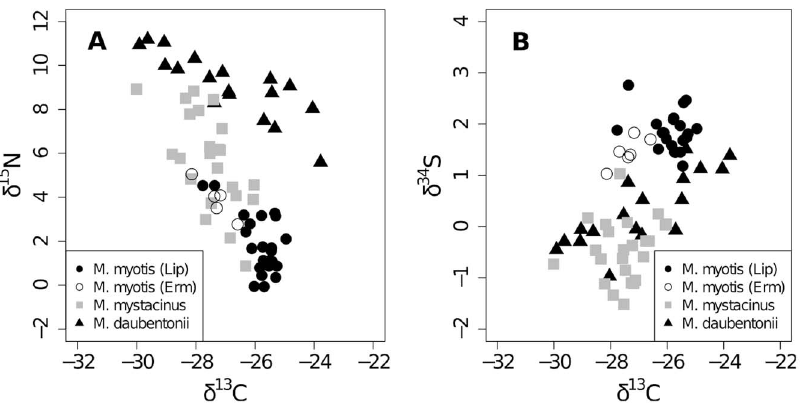
Figure 2. Stable isotope values A. d 15 N versus d 13 C and B. d 34 S versus d 13 C. Plot of stable isotope values A. d 15 N versus d 13 C and B. d 34 S versus d 13 C for Myotis myotis , M. mystacinus and M. daubentonii . Values indicate that each species occupied a different isotopic niche. The population